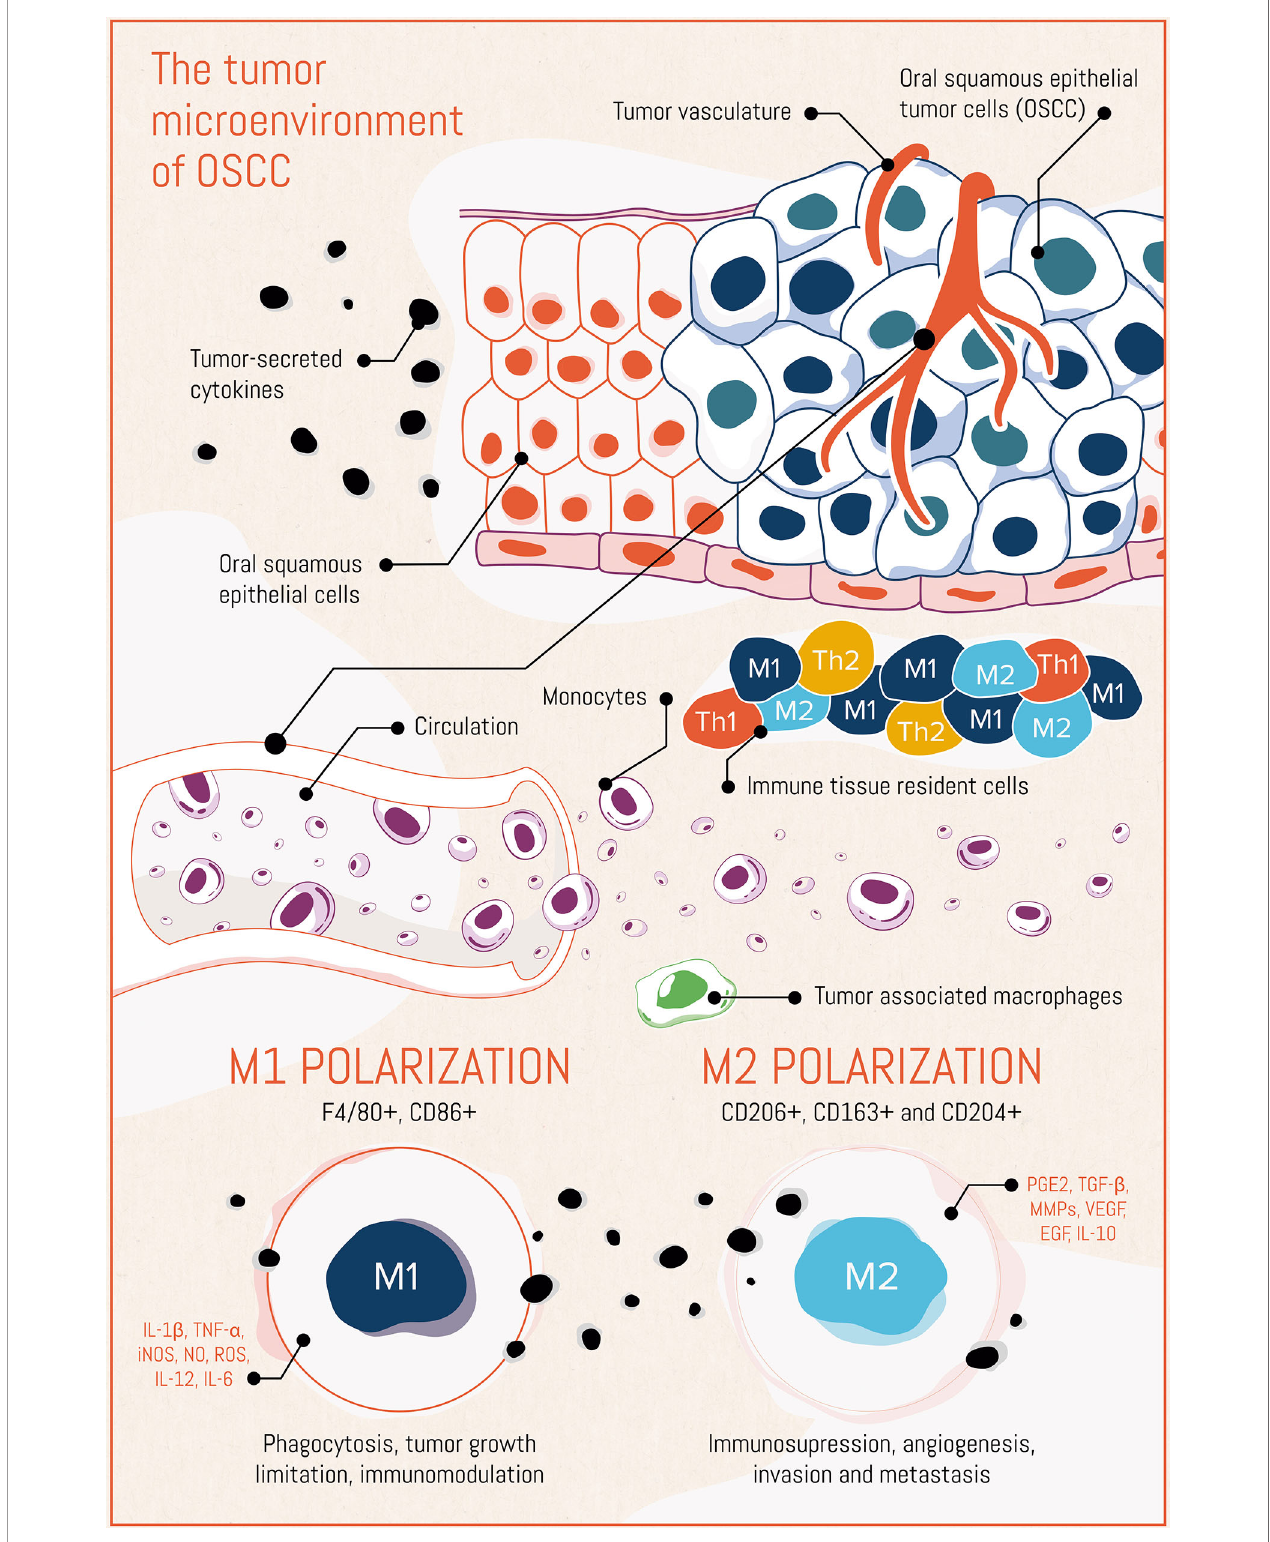
FIGURE 1 | The tumor microenvironment in oral squamous cell carcinoma (OSCC), placing emphasis on the macrophage compartment.